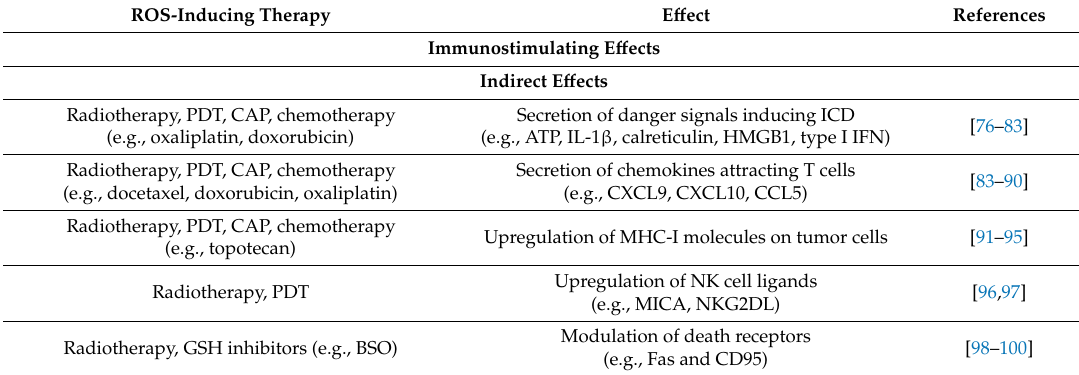
Table 1. Overview of immunomodulating e ff ects of di ff erent ROS-inducing therapies. ROS-Inducing